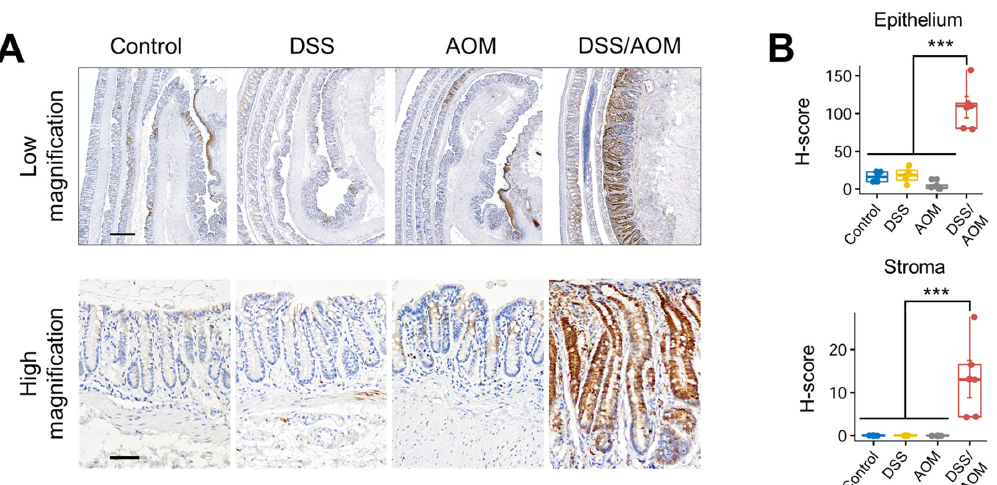
Figure 6. Immunohistochemical analysis of phosphorylated S6 ribosomal protein. ( A ) Representative photomicrographs of phosphorylated S6 immunostaining in the distal colons of control, DSS-, AOM-, and DSS/AOM-treated mice showing low magnification and high magnification fields. Low magnification scale bar = 500 µm and high magnification scale bar = 100 µm. ( B ) H-scores of p-S6 in the epithelium (upper) and stroma (lower) of the distal colonic mucosa. ANOVA p value < 0.001 and post hoc statistical analysis was performed using Student-Newman-Keuls Method; *** p < 0.001, DSS, dextran sodium sulfate; AOM, azoxymethane, DSS/AOM; dextran sodium sulfate + azoxymethane, ANOVA; analysis of variance.